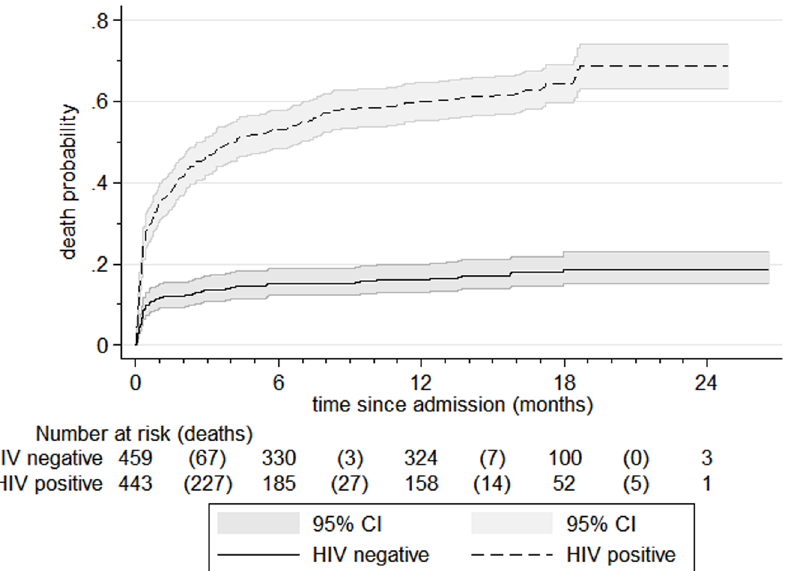
children being removed from further analysis (being ‘censored’). With this denominator change, the y-axis is mortality probability rather than percentage. Whilst our main outcomes focus is on the first year post-discharge, for completeness, data is presented until the last child’s follow-up.